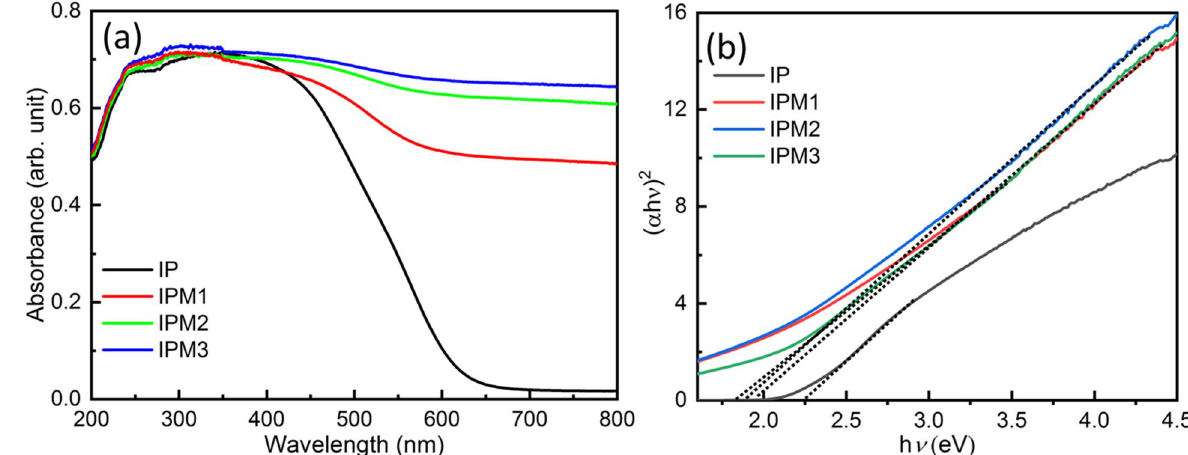
Figure 6. ( a ) UV-DRS studies depicting the variations in the optical absorbance profile for sample IP, IPM1, IPM2, and IPM3, ( b ) Tauc plots for sample IP, IPM1, IPM2, and IPM3.